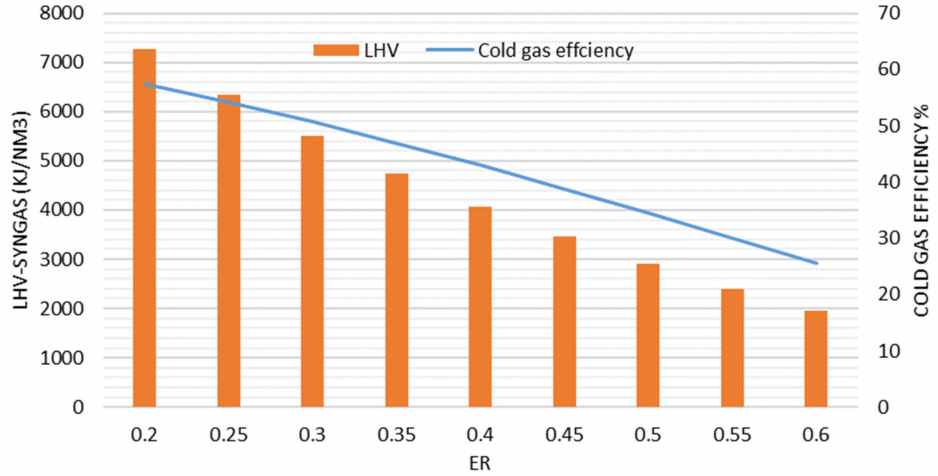
Figure 7. E ff ect of ER on syngas LHV and cold gas e ffi